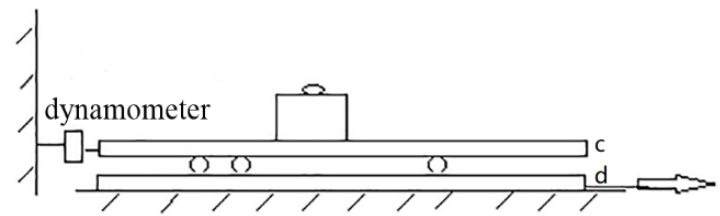
Figure 2. The experimental study on the rolling friction coefficient between proppant and wall.